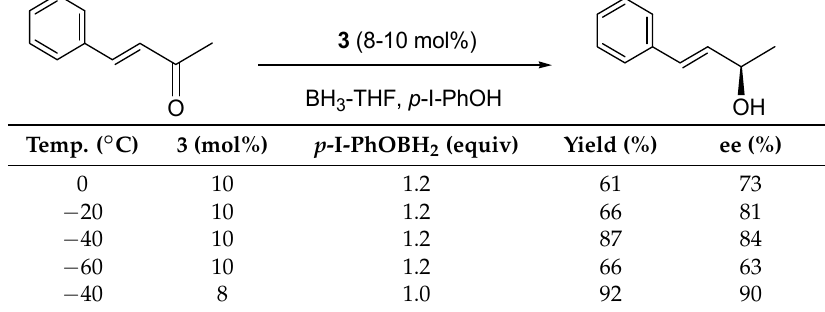
Table 2. Effect of temperature, ligand loading, and borane equivalent on enantioselectivity for the reduction of benzalacetone using chiral lactam alcohol 3 and p -iodophenoxyborane a .